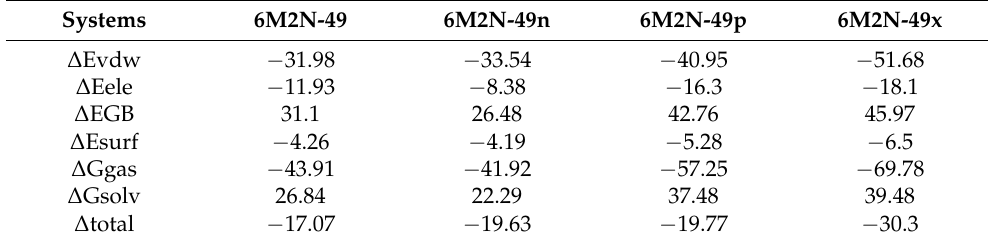
Table 6. Detailed binding free energy calculated by MM/GBSA for all complexes. All the values are given in